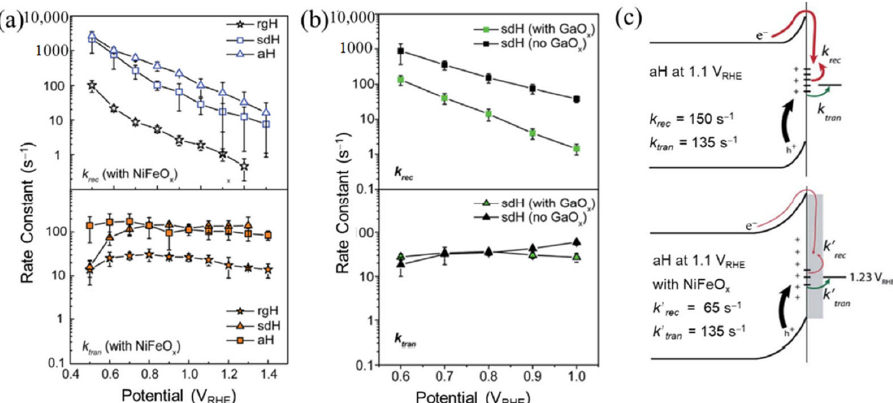
Figure 4. ( a ) Rate constants for hematite photoelectrodes with NiFeO x surface decorations. Top: recombination rate constants for photoelectrodes by three different preparation methods; bottom: surface charge transfer rate constants for the same photoelectrodes. The error bars are standard deviations between different samples. ( b ) Rate constants for hematite treated with GaO x passivation. Top: recombination; bottom: transfer. ( c ) Surface decorations on hematite improve the overall PEC performance by reducing surface recombination. Compared with bare hematite (top), NiFeO x does not change k tran (bottom). Instead, it reduces the recombination rate constant (k rec ) greatly. Reproduced from [56] with permission.